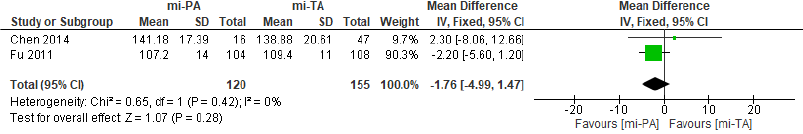
( f ) Forest plot representing analysis of postoperative SBP (mmHg).